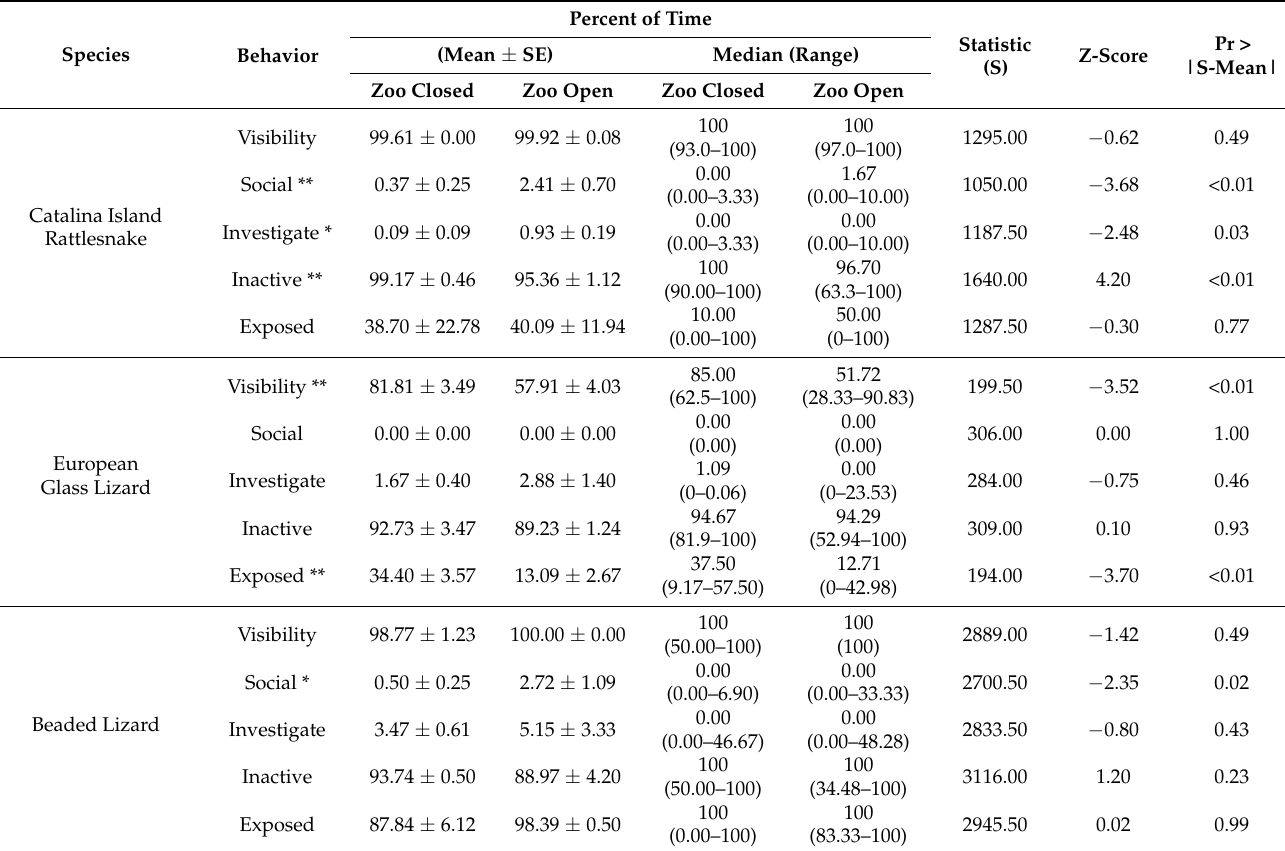
Table 5. Wilcoxon Two-Sample with Monte Carlo Exact Test Results for behavior variables. Significant differences (Pr > |S-Mean| below 0.05) are bolded with an asterisk (*), and Pr > |S-Mean| equal to 0.01 or below are bolded with a double asterisk